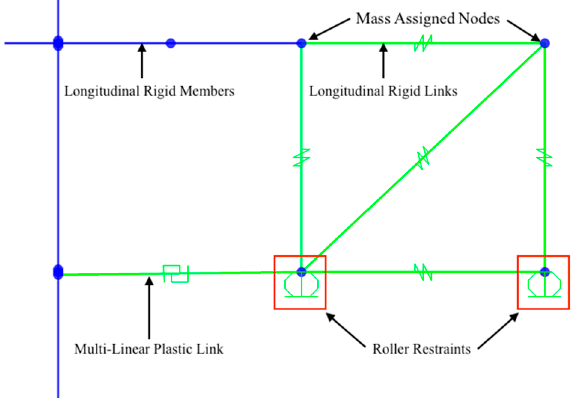
Figure 5. SHJ box-shaped model.